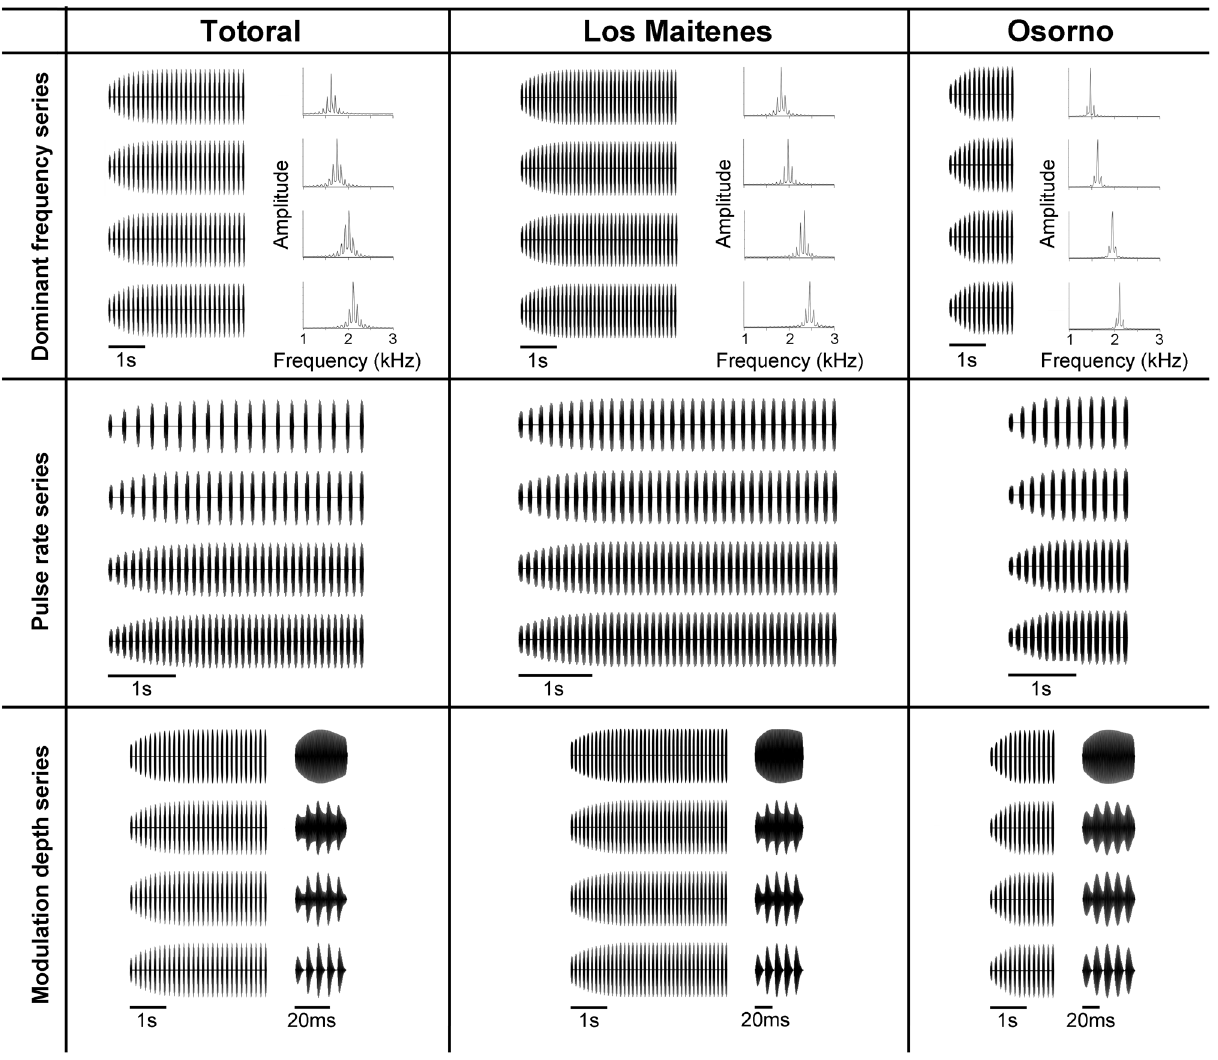
Figure 2. Synthetic stimuli of the Dominant frequency, Pulse rate and Modulation depth series used for each population. For stimuli of the Dominant frequency series, oscillograms of the entire calls and power spectra are shown. For the Pulse rate series only the oscillograms of the entire calls are shown. For stimuli of the Modulation depth series, oscillograms of the entire calls and expanded views of a pulse of each call showing amplitude modulation patterns are shown.